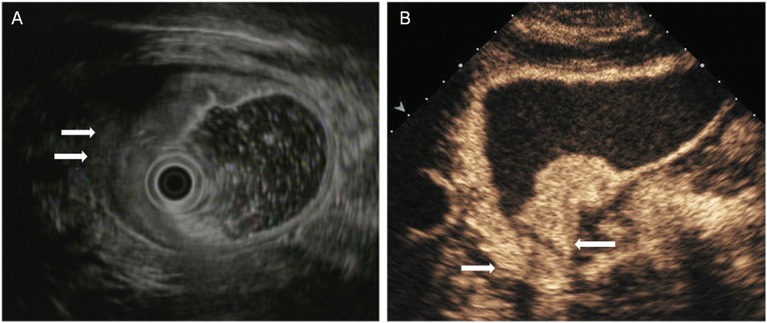
A case with T4 tumor located in the antrum. (A) EUS showed an lesion penetrated the serosal layer and invaded into adjacent tissues (arrow). (B) DCEUS showed the lesion infiltrated to duodenum bulb (arrow).